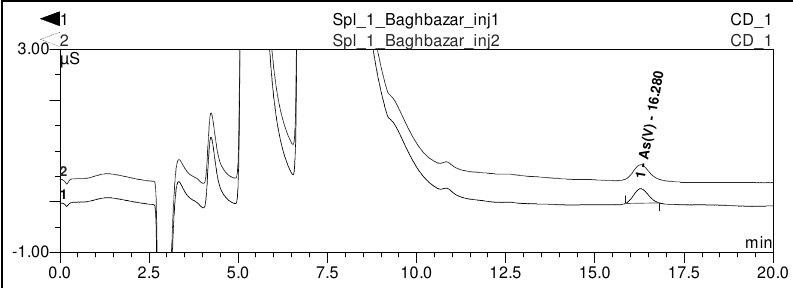
Figure 6. Conductivity detection of sample_1_Baghbazar for arsenate content (duplicate